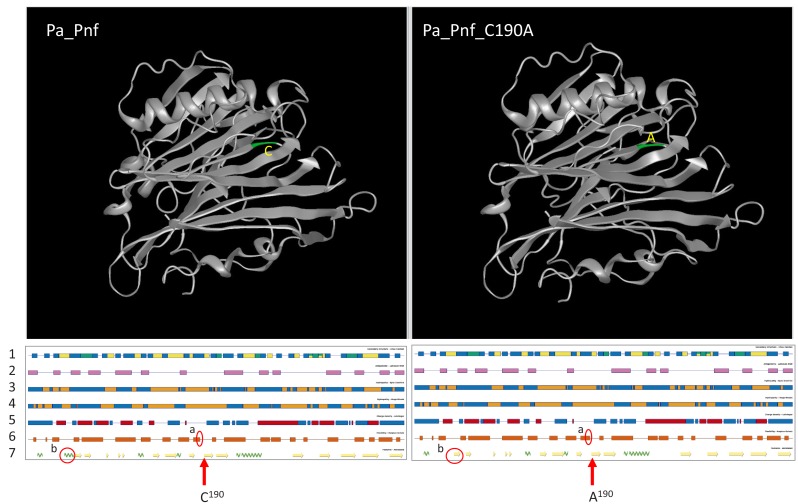
Ab initio structural prediction of the Pnf toxin and toxoid derivative.Top. Predicted structural models of Pnf wild-type protein (Pa_Pnf) and the toxoid (Pa_Pnd_C190A) produced using Phyre2 with a 100% confidence score by comparison to an E. coli CNF1/2 family toxin active site domain (PDB Entry: 1hq0). Visualised using the DNAstar Protean 3D. Location of the active site mutation C190A is shown in green. Bottom. Predicted structural properties of the two proteins. Minor differences between the two models are circled in red (labelled ‘a’ and ‘b’). The numbered tracks are as follows; (1) Chou-Fasman Secondary Structure, (2) Jameson-Wolf Antigenicity, (3) Kyte-Doolittle Hydropathy, (4) Hopp-Woods Hydropathy, (5) Lehninger Charge Density, (6) Karplus-Schutz Fexability, (7) Feature Annotation.